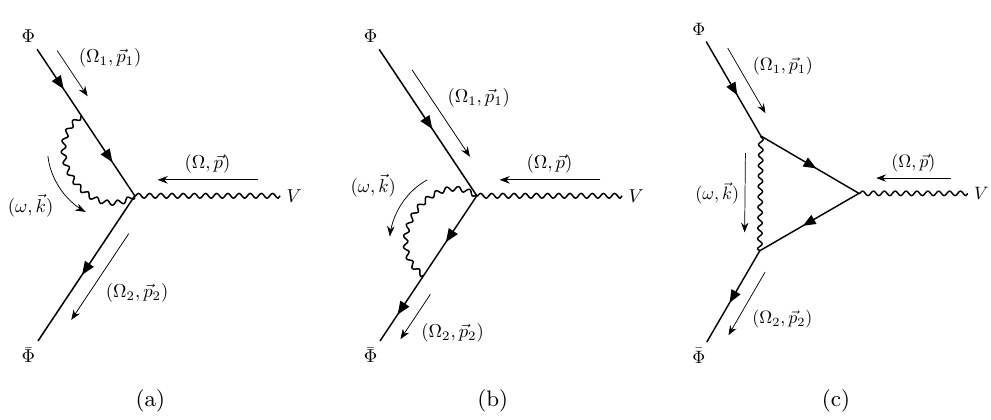
Figure 5 . One-loop diagrams contributing to the quantum corrections of the three-point vertex ¯Φ h V Φ i . The graphs (a) and (b) are mapped into each other by reversing the arrows along the chiral